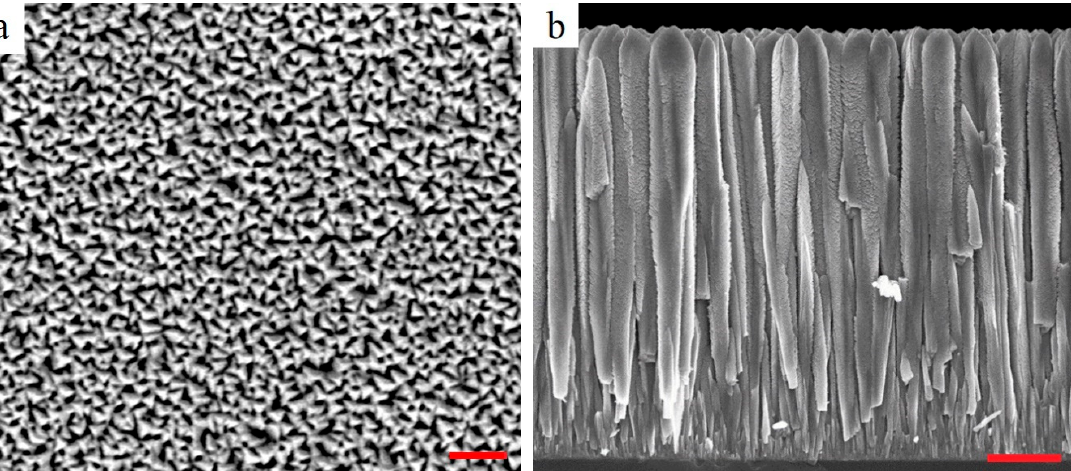
Figure 3. ( a ) Top-view (magnification: 25,000×) and ( b ) cross-section SEM images (magnification: 40,000×) of TiN coating on Si-wafer. Scale bar: 1 µm.